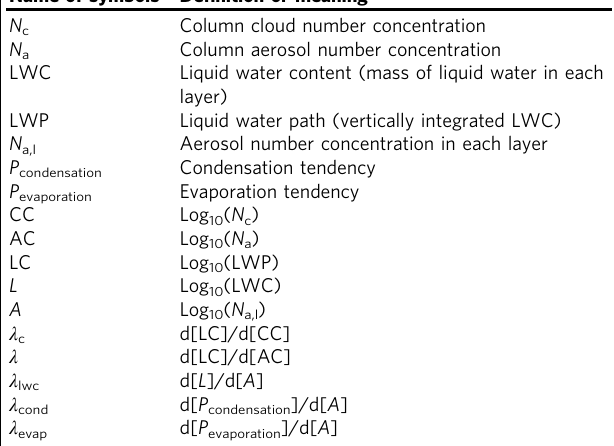
Table 1 Summary of the notation and de fi nition of symbols Name of symbols De fi nition or